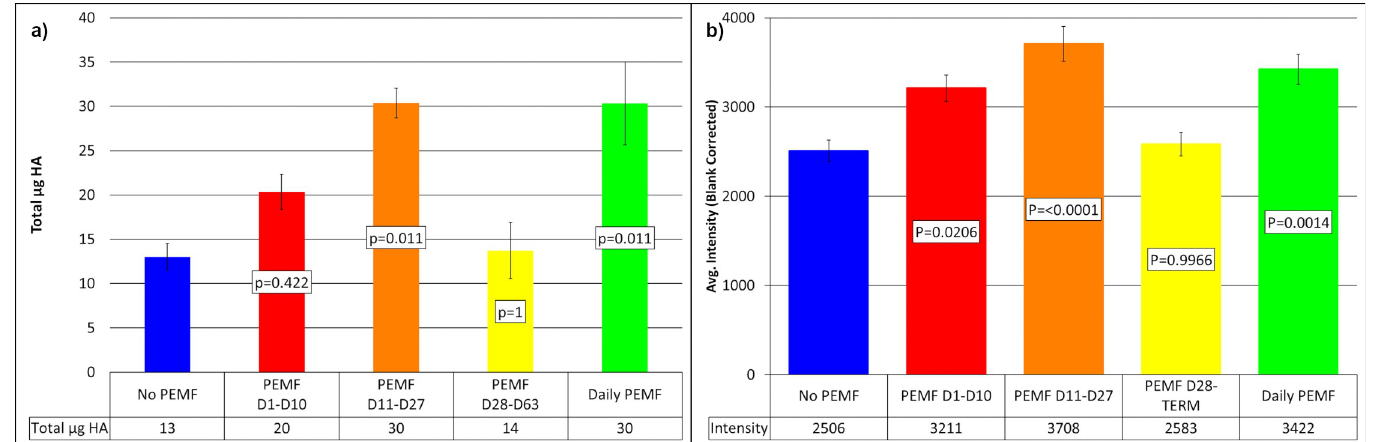
Fig 6. Mineralization measured by micro-CT and ARS early in culture. (a) Micro-CT of samples at Day 27 of culture. Standard error with n = 3 per group. (b) ARS fluorescence of samples at Day 23. Standard error with P = Tukey HSD, n = 9. Both analysis techniques yielded similar stimulation of mineralization by PEMF. Differences between groups are dependent on the time of analysis relative to the onset of PEMF. Day 28-Day 63 samples have not yet been exposed to PEMF and thus match no-PEMF controls.